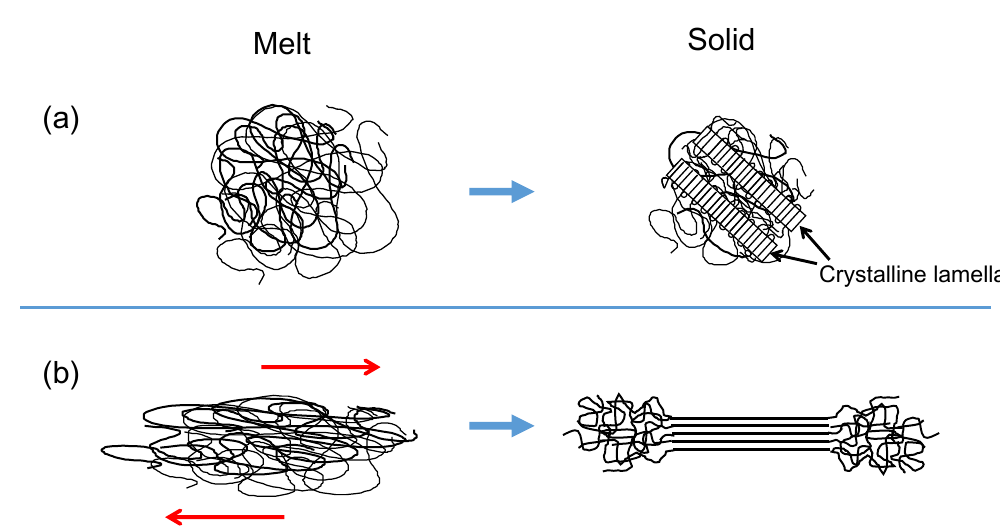
Figure 1. Schematic illustrations of crystallization from ( a ) an equilibrium melt and ( b ) a flowing